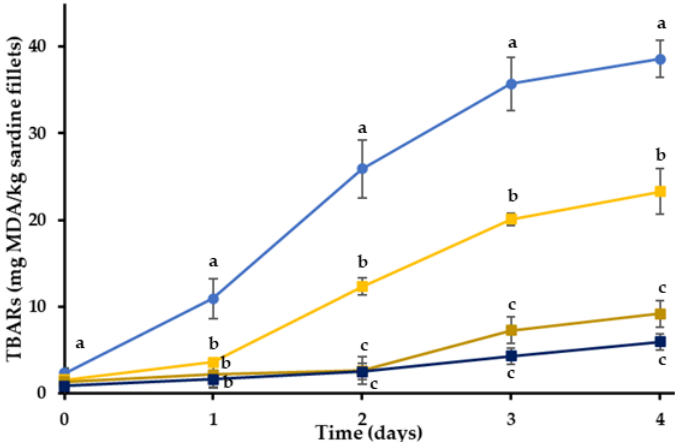
Figure 3. Oxidation values of sardine fillets with or without incorporated RE coating during storage at 4 °C. ( ● ) C: control-uncoated fillets; ( ■ ) BG: bigel coating; ( ■ ) BGHR: bigel coating with added RE in the aqueous phase; ( ■ ) BGOR: bigel coating with added RE in the lipid phase. a – c Different letters in the same day indicate significant differences ( p < 0.05).